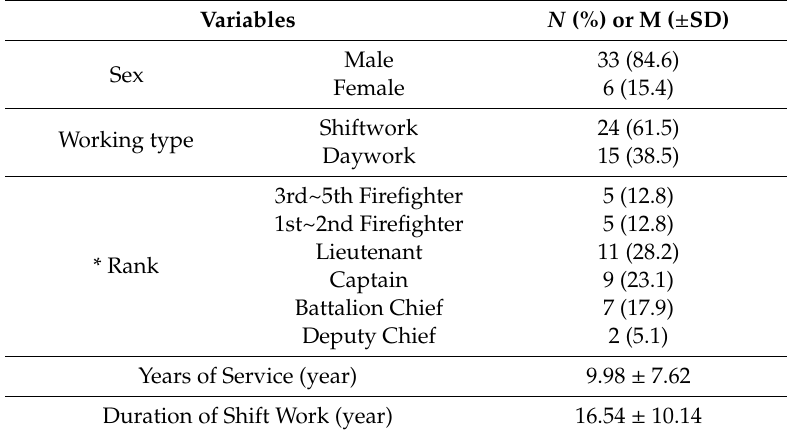
Table 2. Demographics and sample characteristics ( n =